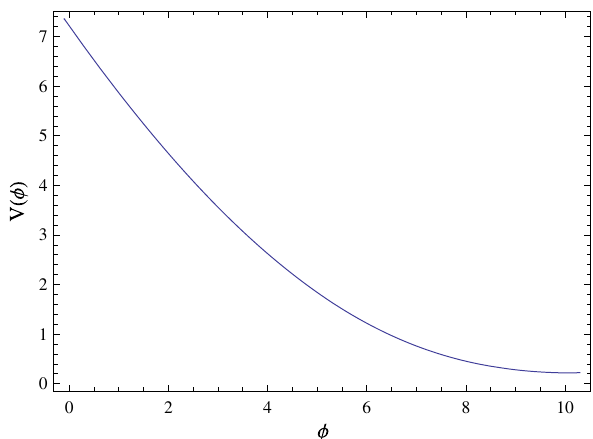
Fig. 24 Variation of V (φ) with the variation of φ for the JBP param- eterization (Model III)